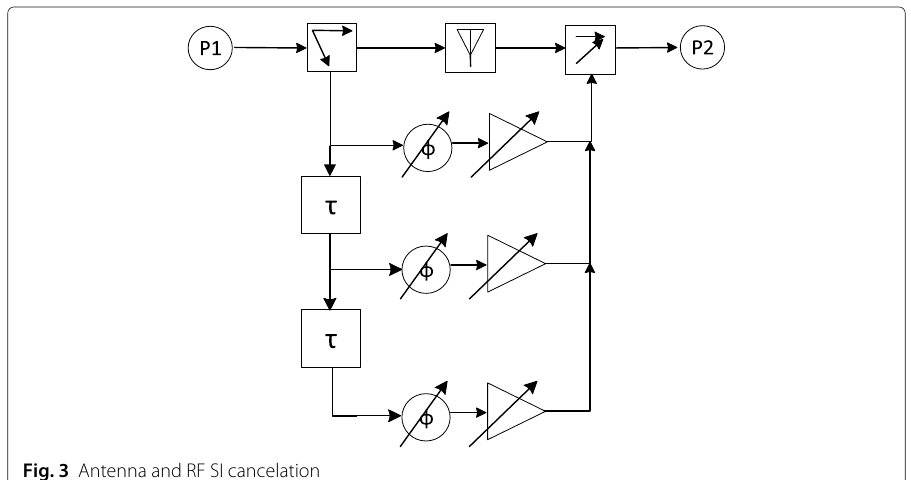
Fig. 3 Antenna and RF SI